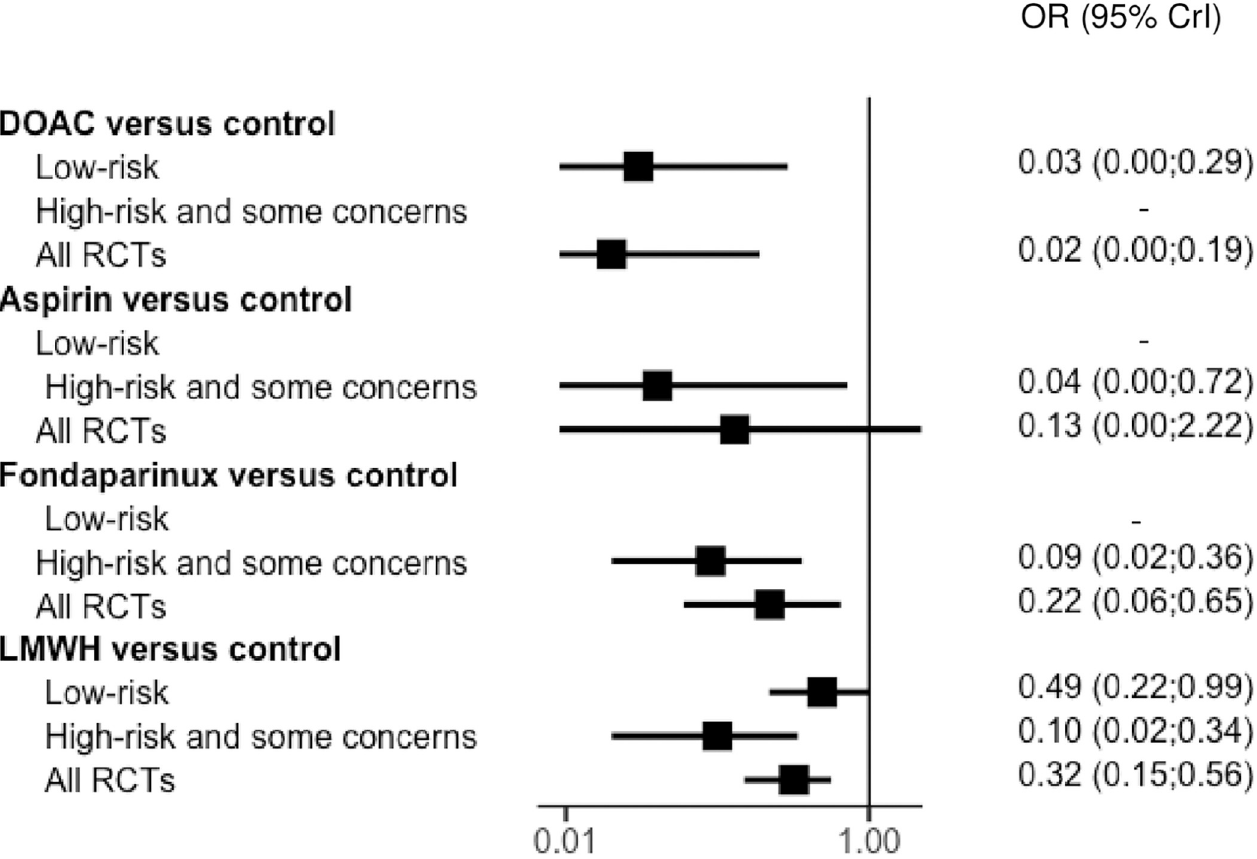
Fig 4. Network forest plot according to the risk of bias for the main outcome: major VTE with OR (points) and their 95% CrIs (lines). DOAC, direct oral anticoagulant; LMWH, low molecular weight heparin; OR, odds ratio; RCT, randomized controlled trial; VTE, venous thromboembolism; 95% CrI, 95% credible